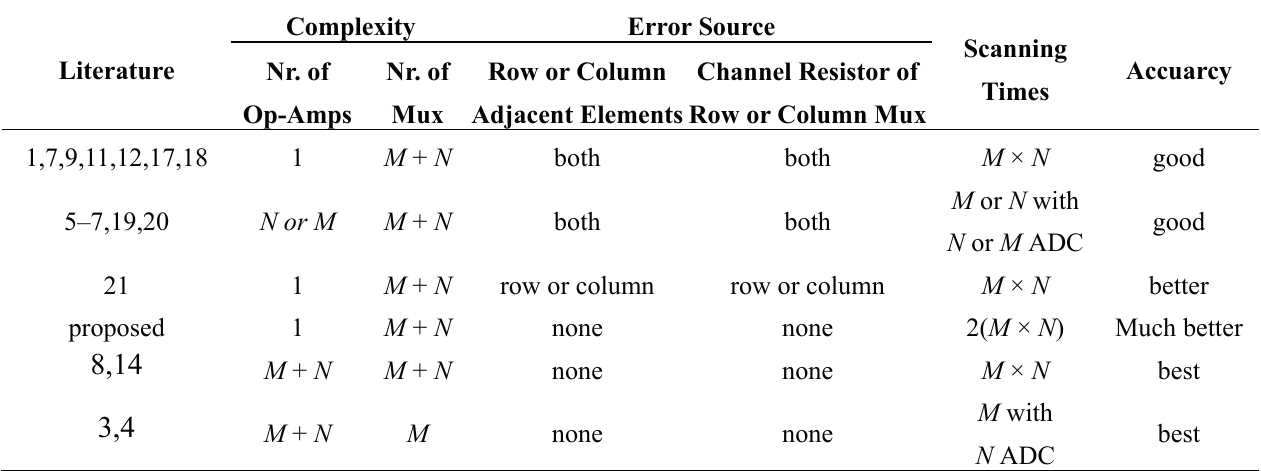
Table 3. Comparison of different implementations of the M × N networked resistive sensor